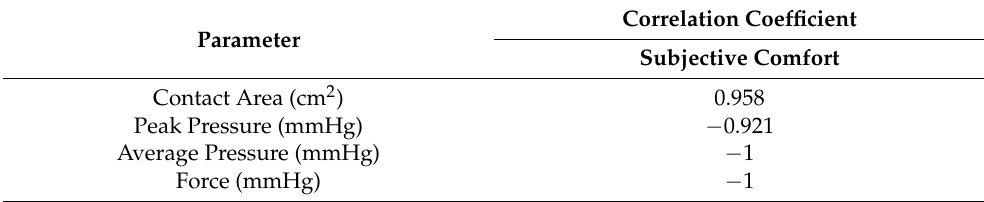
Table 5. Correlation between subjective comfort and body pressure parameters.